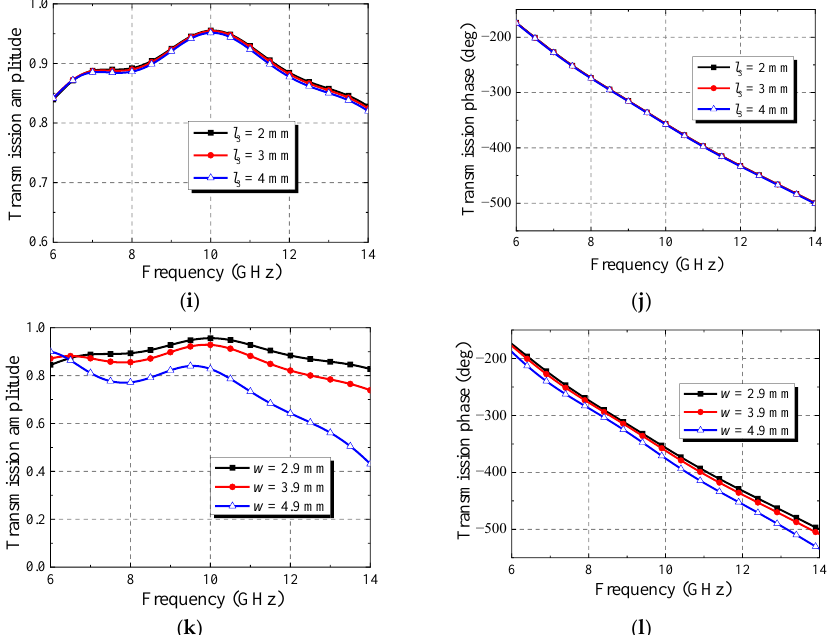
Figure 5. The effect of different parameters on the transmission performance of the element: ( a ) the effect of h 1 on amplitude; ( b ) the effect of h 1 on phase; ( c ) the effect of h 2 on amplitude; ( d ) the effect of h 2 on phase; ( e ) the effect of l 1 on amplitude; ( f ) the effect of l 1 on phase; ( g ) the effect of l 2 on amplitude; ( h ) the effect of l 2 on phase; ( i ) the effect of l 3 on amplitude; ( j ) the effect of l 3 on phase; ( k ) the effect of w on amplitude; ( l ) the effect of w on phase.